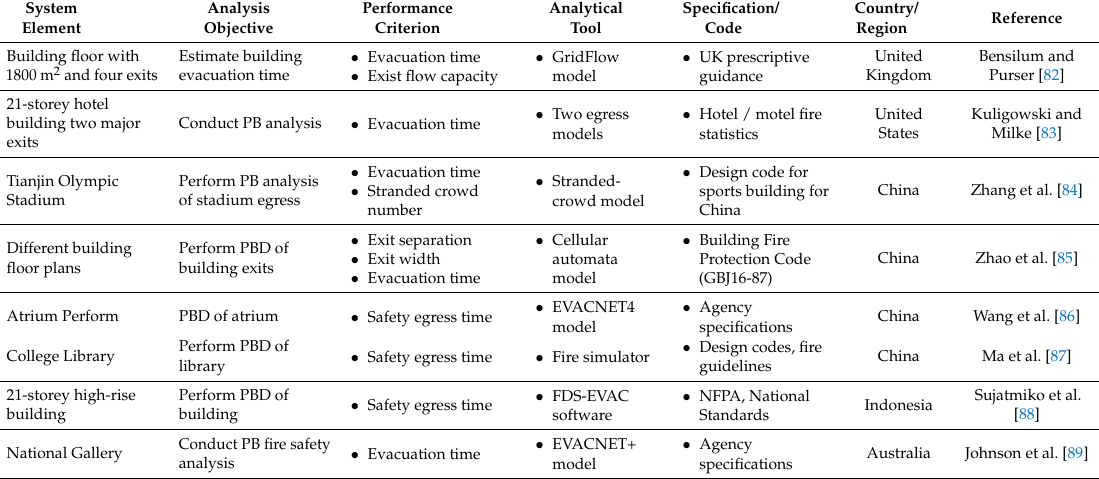
Table A6. Characteristics of building architectural design for evacuation applications.